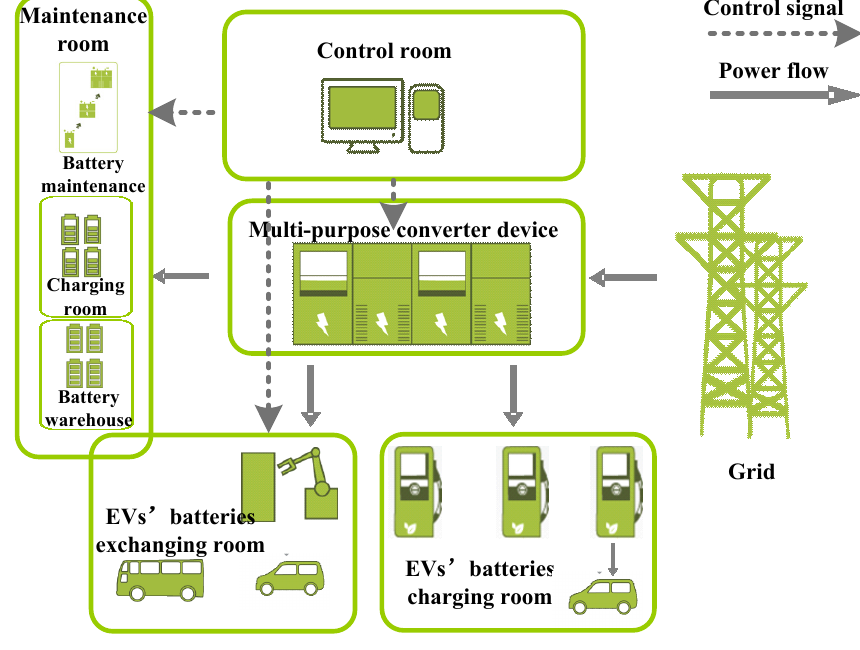
Figure 5. Layout of charge exchange